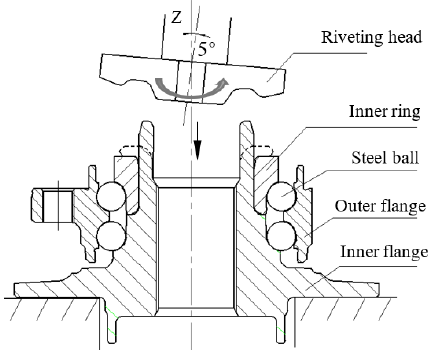
Figure 1. Schematic of riveting assembly process.